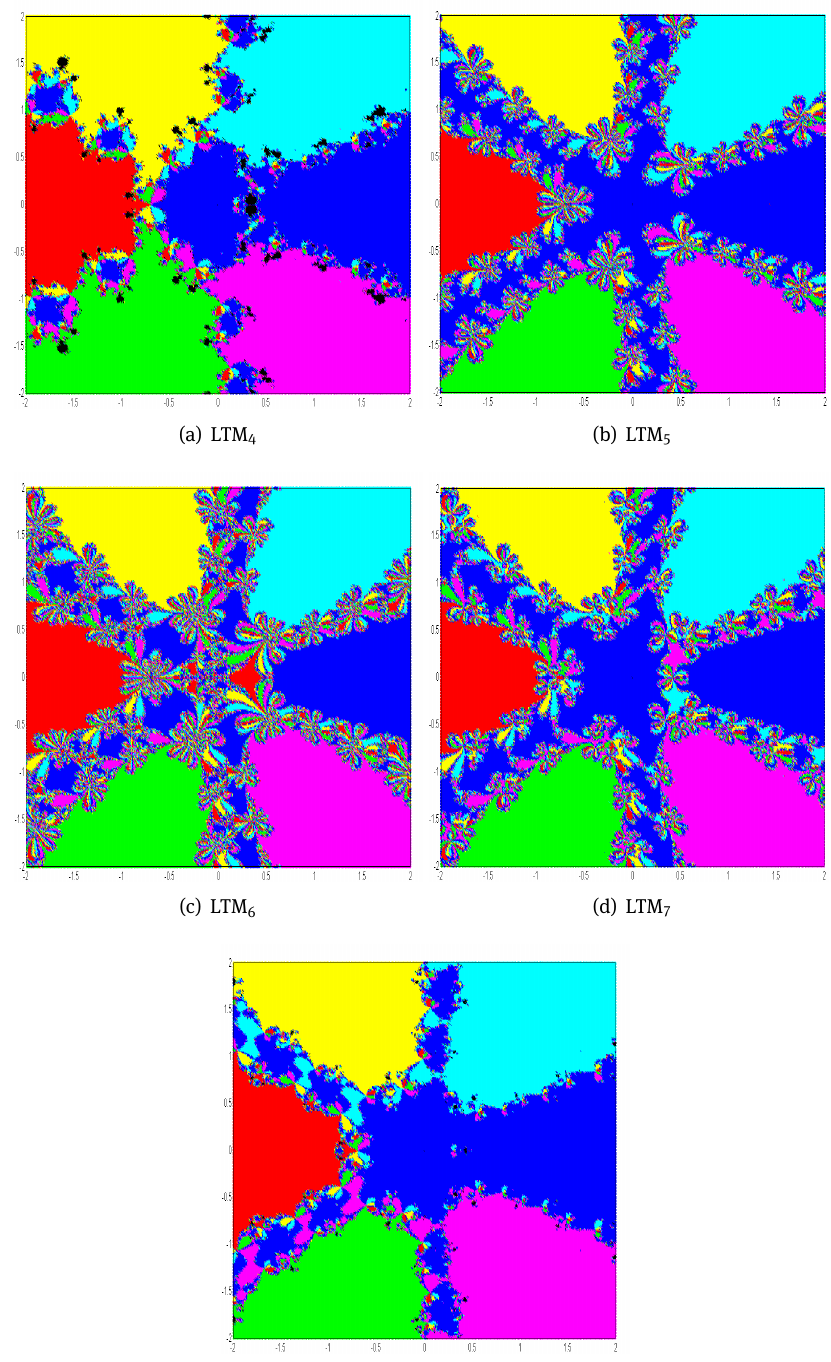
Figure 9: Basins of attraction of the methods LTM 4 , LTM 5 , LTM 6 , LTM 7 and LTM 8 respectively for P 3 ( z ) = z 6 + z − 1